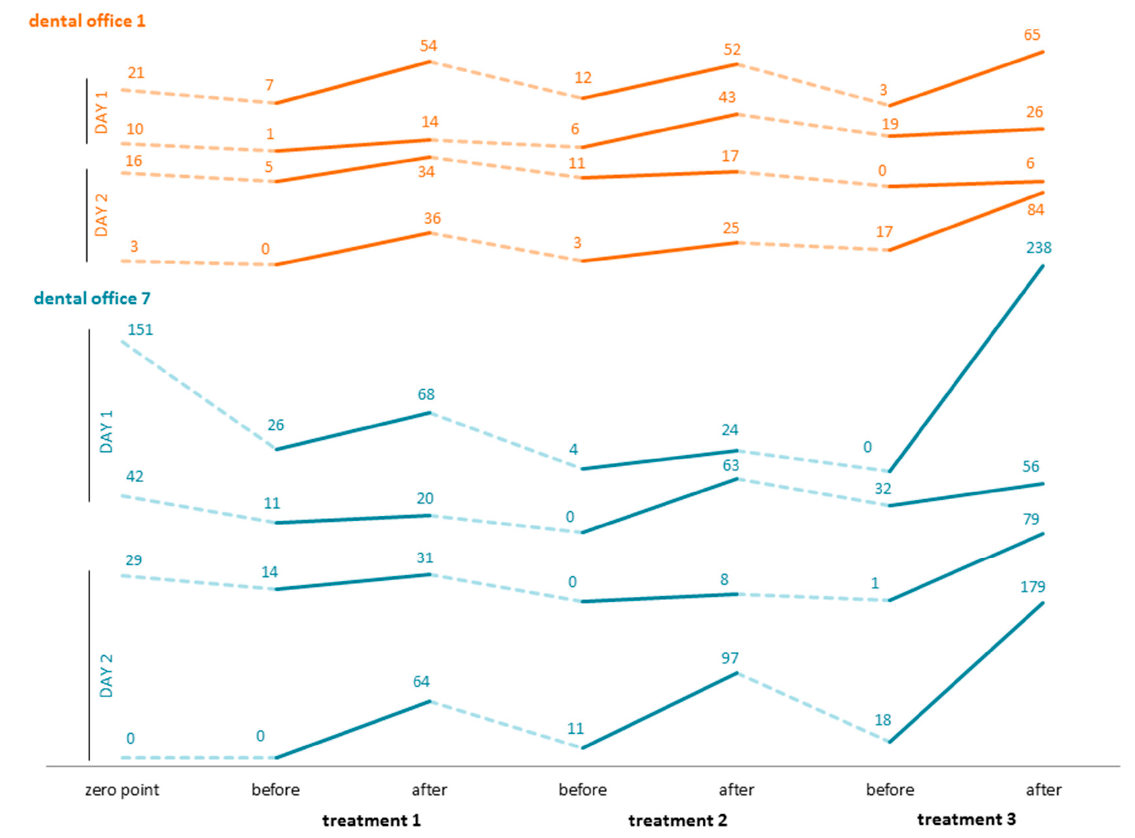
Figure 6. Protein concentrations over the course of two days.